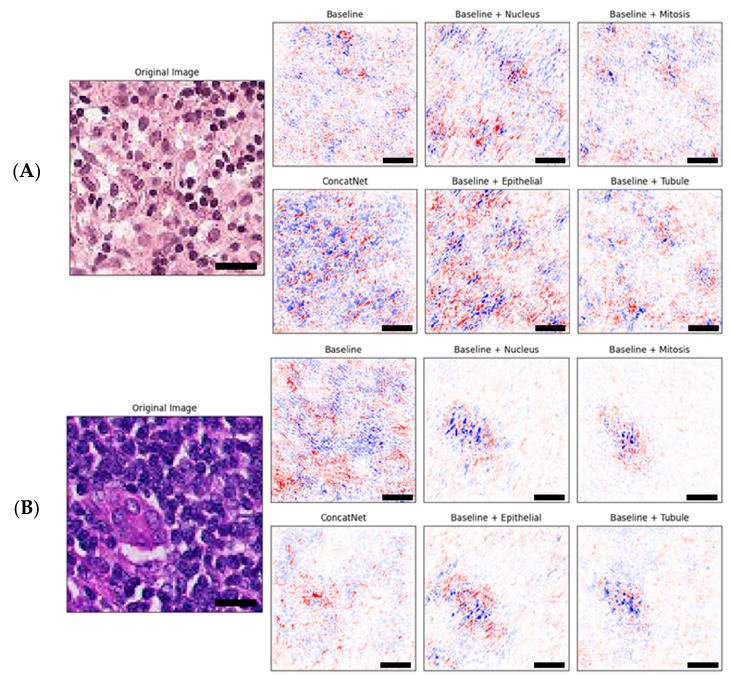
Figure 3. Example sets of explanations of model attribution for each of the baseline and the proposed models evaluated as compared to the original input image shown on the left. Red is positive attribution towards classification and blue is negative attribution towards classification. Scale bars (black) are shown for 10 microns (10 μ m). Original (input) image for ( A ) shows a benign tissue section while original image for ( B ) contains malignant tumor cells.